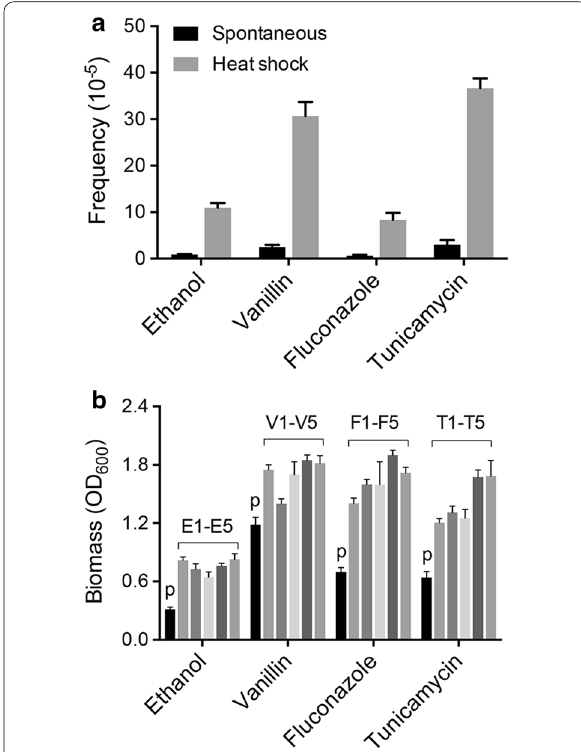
Fig. 6 Heat shock drives fast phenotypic variations in yeast population. Experiments were performed three times, and the means are shown here. Error bars represent the standard deviation. a The frequency of resistant JSC25‑1 isolates appeared on the solid YPD medium containing 120 g/L ethanol, 0.3 mg/L fluconazole, 1.2 g/L vanillin, and 4 mg/L tunicamycin. In this experiment, about 1 viable cells were plated on each plate. b Comparison of biomass formation (OD 600 ) in yeast isolates in liquid YPD medium containing 70 g/L ethanol (E1–E5), 0.15 mg/L fluconazole (F1–F5), 0.8 g/L vanillin (V1–V5), and 1.5 mg/L tunicamycin (T1–T5). The OD 600 of each sample was determined at the 12 h time point. The JSC25‑1 parental strain